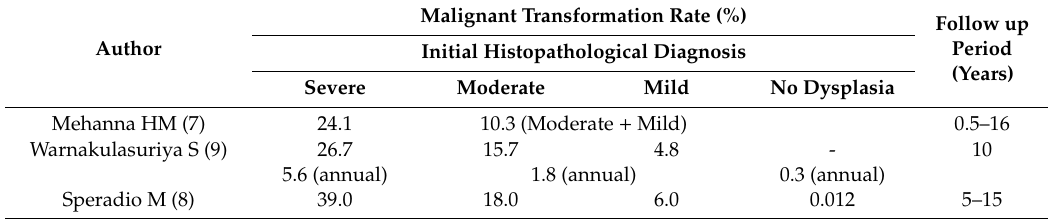
Table 1. The transformation rates of various grades of